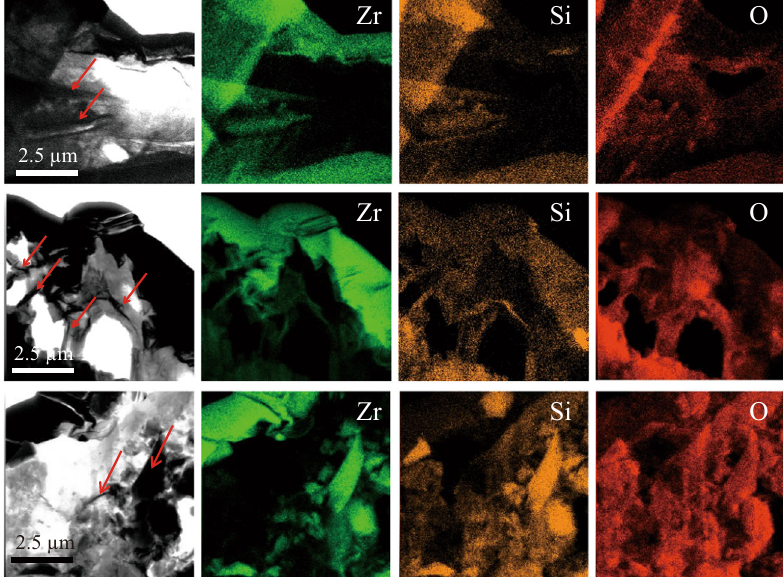
Fig. 11 The elemental mapping by EDS near the surface of the zircon. The scale bar is 2.5 μ m.